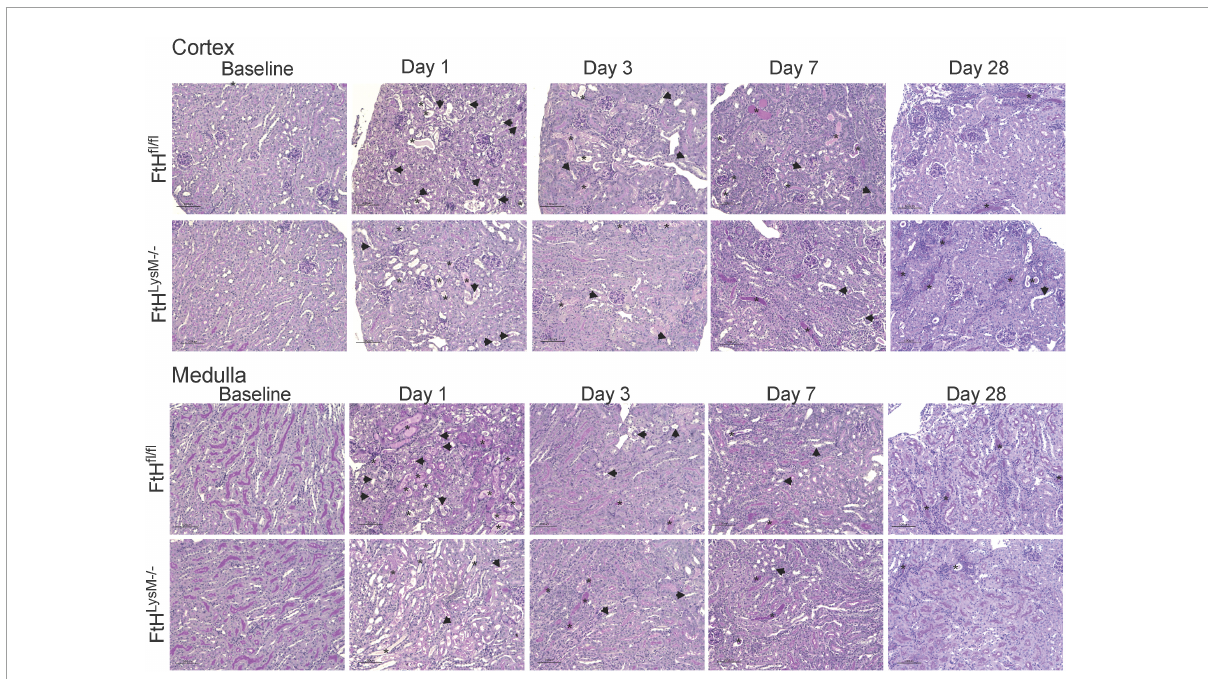
FIGURE2 Temporal changes in tubulointerstitial damage following rhabdomyolysis. Representative micrographs demonstrating tubulointerstitial damage in the cortex (upper panel) and outer medulla (lower panel) of kidneys from FtH fl / fl and FtH LysM − / − mice after glycerol administration. Asterisk indicates tubular casts and arrowheads indicate tubular epithelial cell necrosis. Transverse kidney sections were stained with periodic acid–Schiff. n = 4–6 per group. The scale bar represents 100 µ